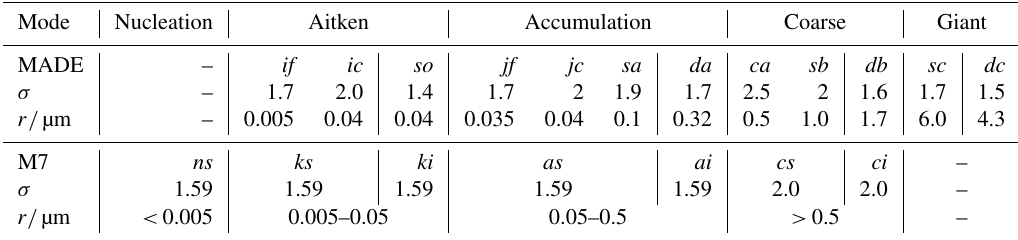
Table 1. Comparison of modal parameters for MADE and M7 modes. Each mode is identified by a two-letter abbreviation (italic font), which allows us to identify its chemical composition in Fig. 1. Modal standard deviation is denoted by σ . Modal median radii of the number distributions, r , refer to initial and emission radii for MADE. In contrast to MADE, M7 features a mode repartitioning ensuring that the radii of M7 modes are restricted to the indicated ranges. Mode reorganization in MADE is limited to ensure that the radii of Aitken modes remain smaller than those of accumulation modes. MADE and M7 modes are grouped to show